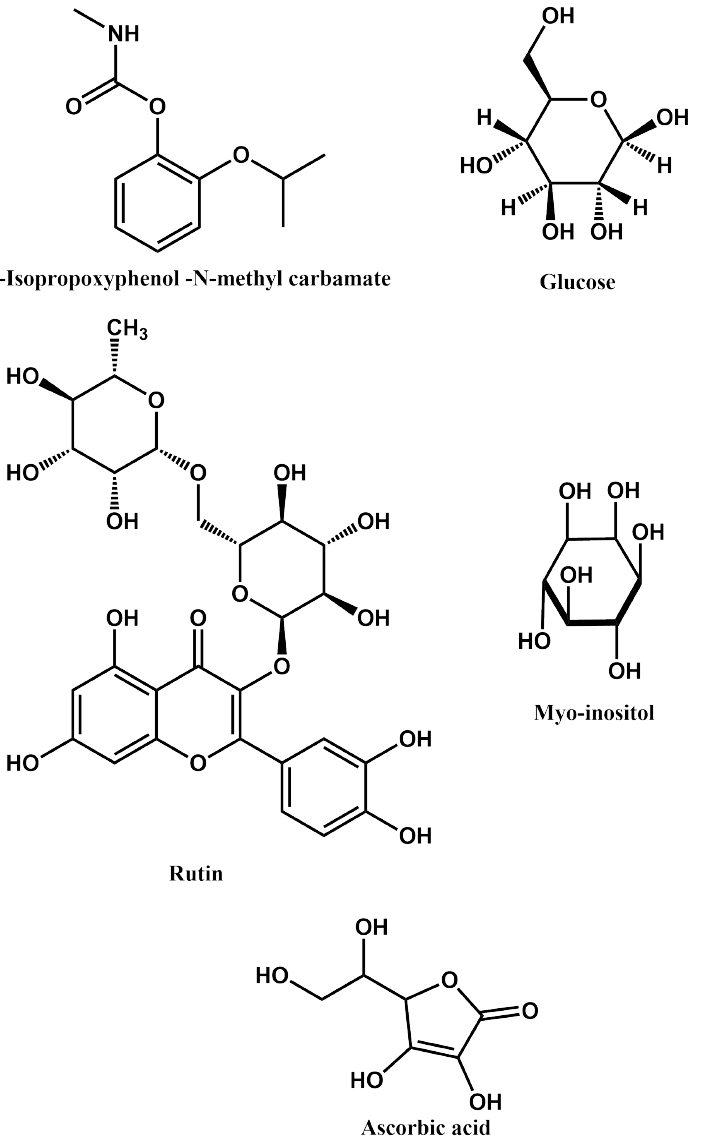
Figure 7. Structural formulae of some bio-active substances that can be detected using MIPPy- based